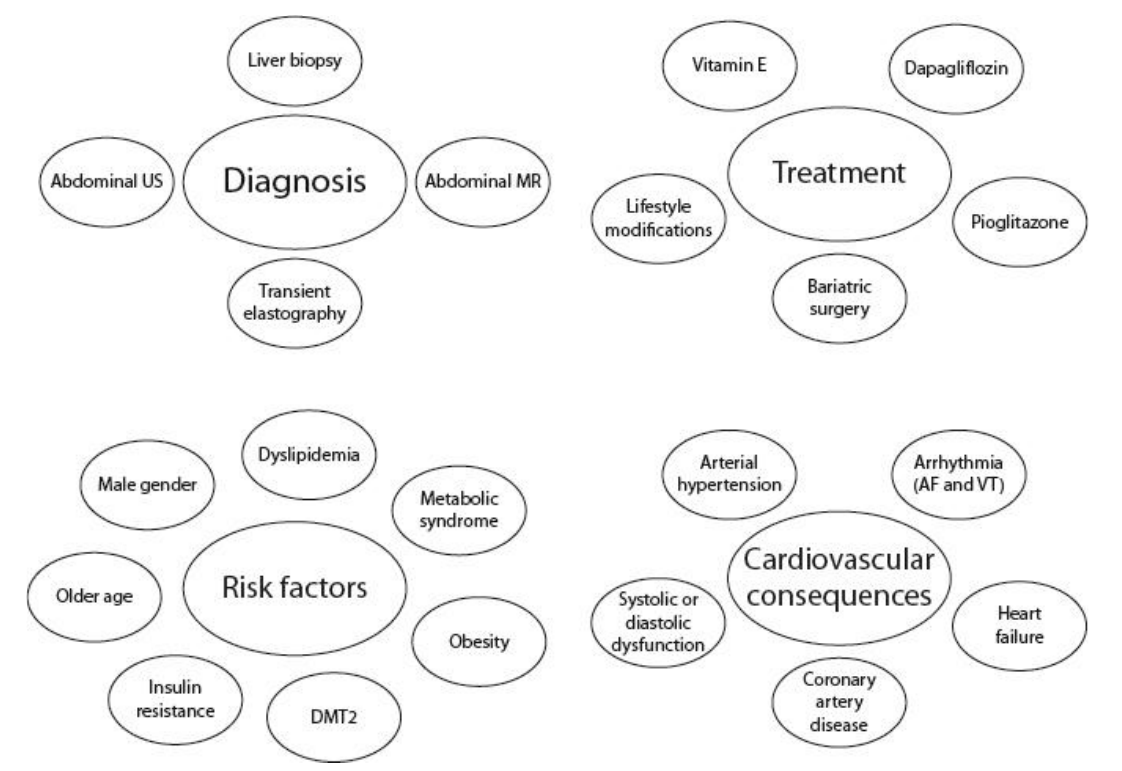
Scheme 1. Diagnosis, treatment, risk factors, and cardiovascular consequences of non-alcoholic ste-